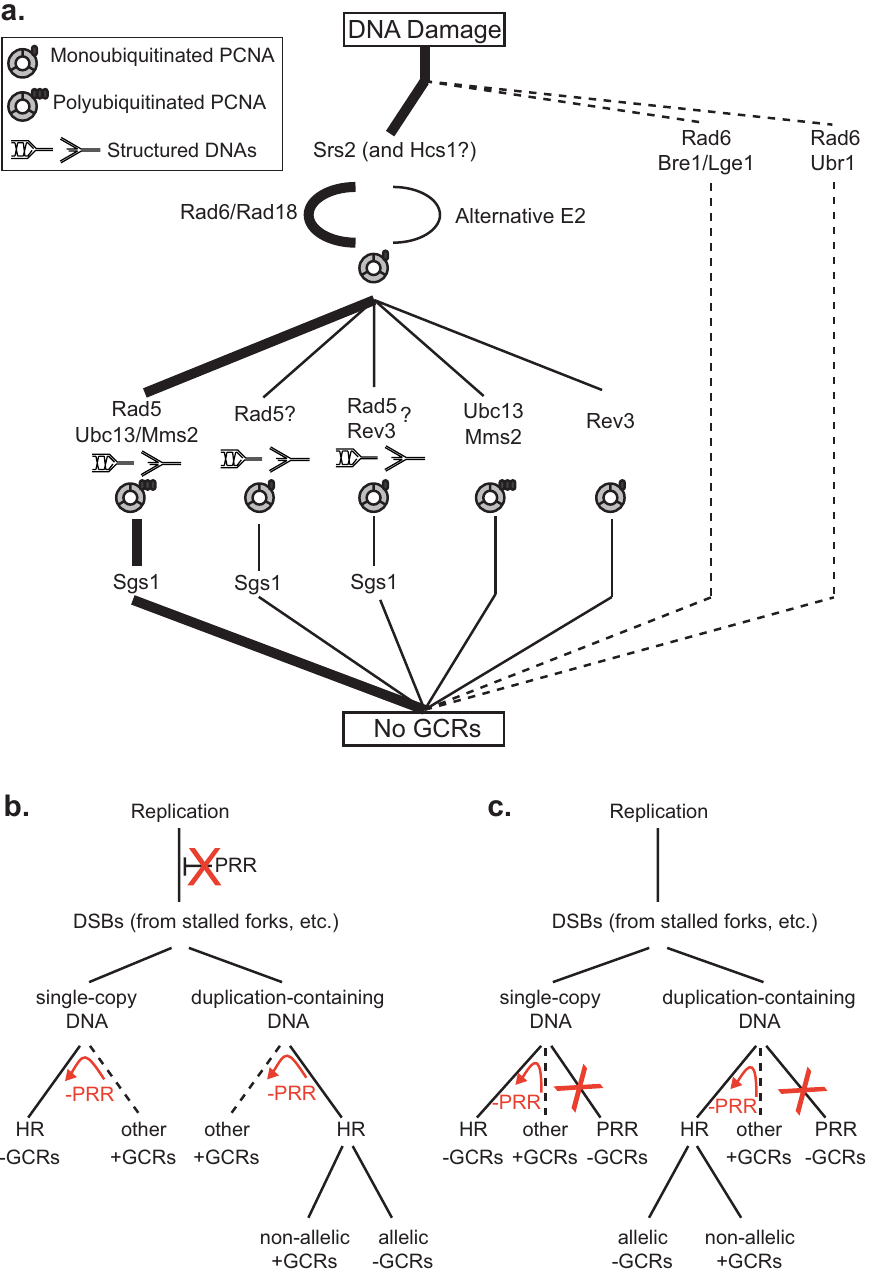
Figure 2. Models for the suppression of duplication-mediated GCRs by PRR. A. The most important RAD6 -dependent pathway that suppresses duplication-mediated GCRs (thick lines) corresponds to the ‘‘error-free’’ PRR branch, which is downstream of Srs2. Other Rad6- and Rad18- dependent branches are less important (thin lines). The presence of specific PCNA and DNA states are inferred based on the genes involved in the pathway. Sgs1 appears to act downstream of the Rad5-dependent branches. The existence of Rad5 branches that are independent of Ubc13 and Rev3 that could be dependent upon Rad6 and Rad18 or independent of Rad6 is inferred by the observation of synergistic interactions between mutations in RAD5 and mutations in RAD6 , UBC13 and REV3 . Our data do not directly address the previously identified Rad5- and Rev3-dependent branch [46]. B. PRR could potentially suppress duplication-mediated GCRs by preventing replication damage from being converted into DSBs and other HR substrates. Suppression of single-copy GCRs also requires that PRR promotes other GCR forming pathways (such as NHEJ and de novo telomere addition) or requires PRR-dependent suppression of HR. C. PRR could potentially suppress duplication-mediated GCRs by functioning as an alternative to HR. Suppression of single-copy GCRs also requires that PRR promotes other GCR forming pathways (such as NHEJ and de novo telomere addition) or requires PRR-dependent suppression of HR. The red arrows and Xs in B and C indicate the consequences of PRR defects. xrs2 D mutants [71–74] have increased rates of both single-copy PRR must function either by preventing damage from becoming sequence- and duplication-mediated GCRs [27,75] and likely have HR substrates (Figure 2b) or as an alternative pathway to HR in an increased basal level of spontaneous DNA damage. Rather, the processing of damage (Figure 2c). PRR defects would thus